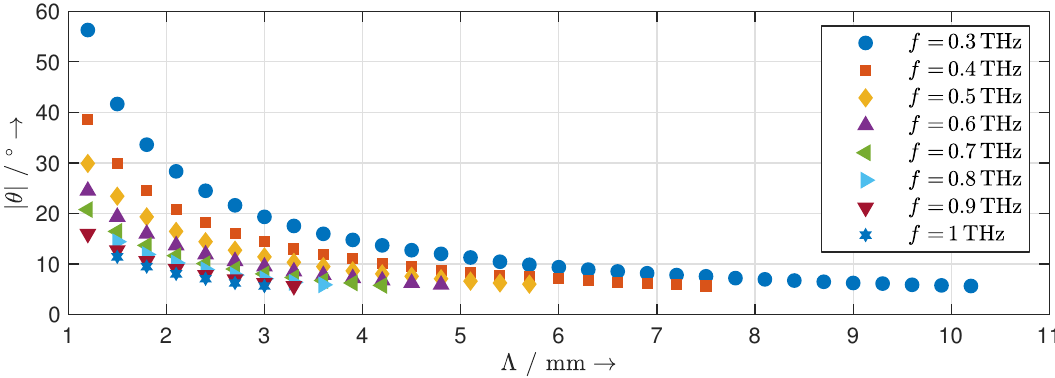
Figure 8. Calculated achievable steering angles of the MEMS reflection grating at different frequencies.